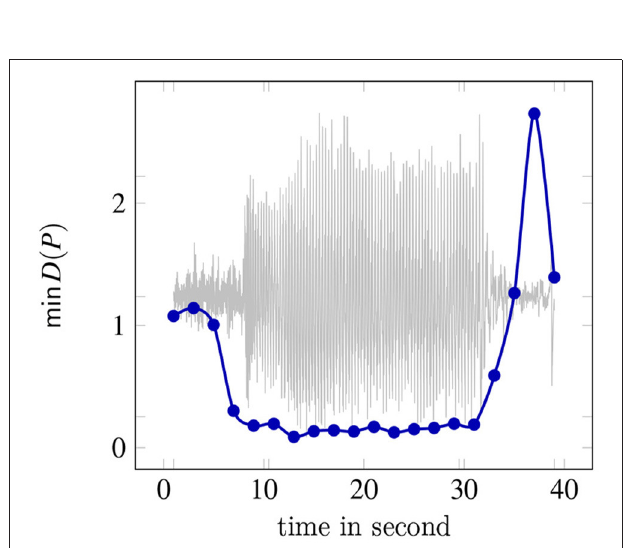
FIGURE 1 | Two types of saddle-foci: On the left the two-dimensional eigenmanifold is unstable and the one-dimensional eigenmanifold is stable, while on the right it is vice versa.